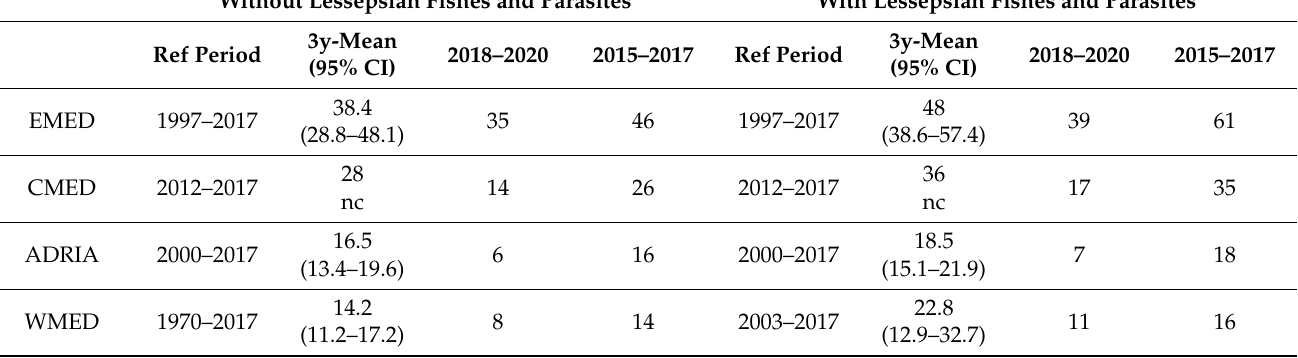
Table 3. Proposed reference periods and their threshold values (3-y segment means) for the 4 Mediter- ranean subregions based on the 3-year interval dataset. The 95% confidence intervals serve as a simple basis for comparison with actual new NIS numbers for the last 3-year periods (2015–2017 and 2018–2020). nc: not